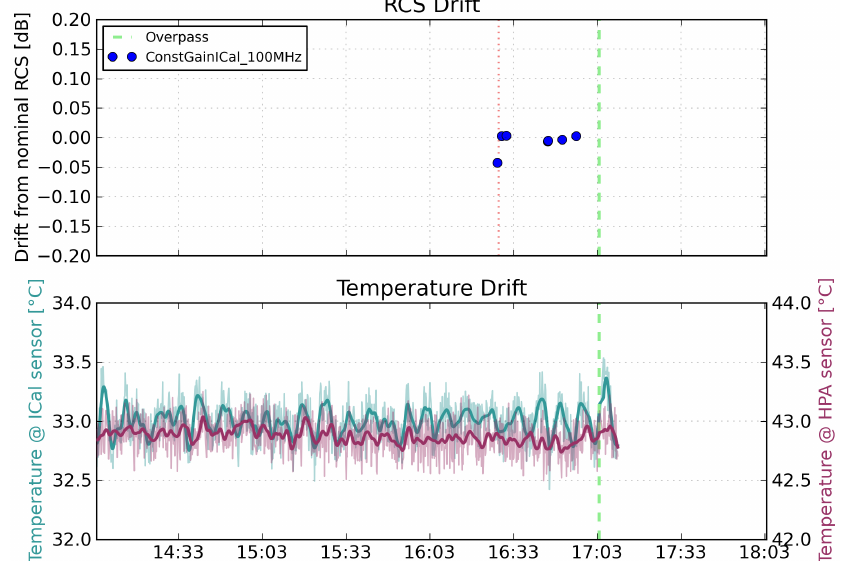
Figure 9. Estimated transponder drift and temperature stability (main influence for gain drift) for the overpass on 21 April 2013. The transponder operates with its nominal loop gain if a relative drift of 0dB is detected. The loop gain was adjusted at 16:30 (red dotted line), after which the drift was monitored (blue circles) until the overpass (dashed green line). After drift correction, the drift is estimated to be with high probability within the range [ 0 . 02 , 0 . 02 ] dB at 17:03 −